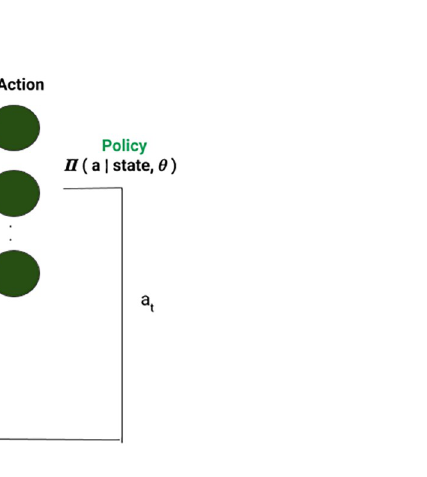
Fig 5. Dialogue policy optimization through a Deep Q